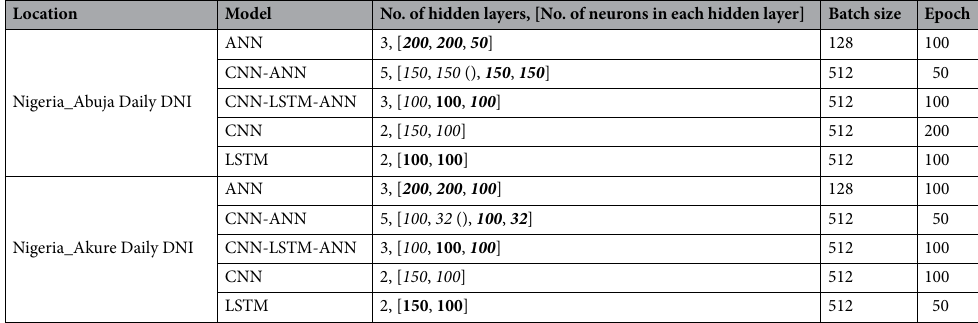
Table 4. Optimal AI training parameters for daily DNI task. The number of neurons in the hidden layers of the ANN models are written in bold italic; LSTM models in bold; CNN models in italics.